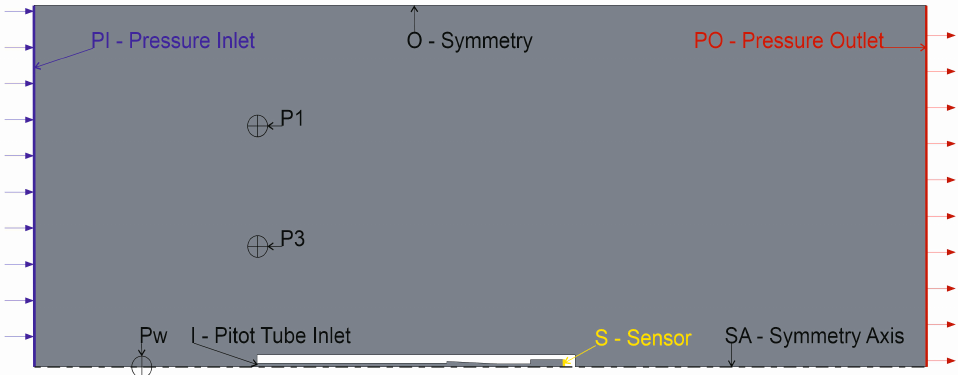
Figure 5. The geometry of the computational domain. The locations of the checkpoints have been marked.